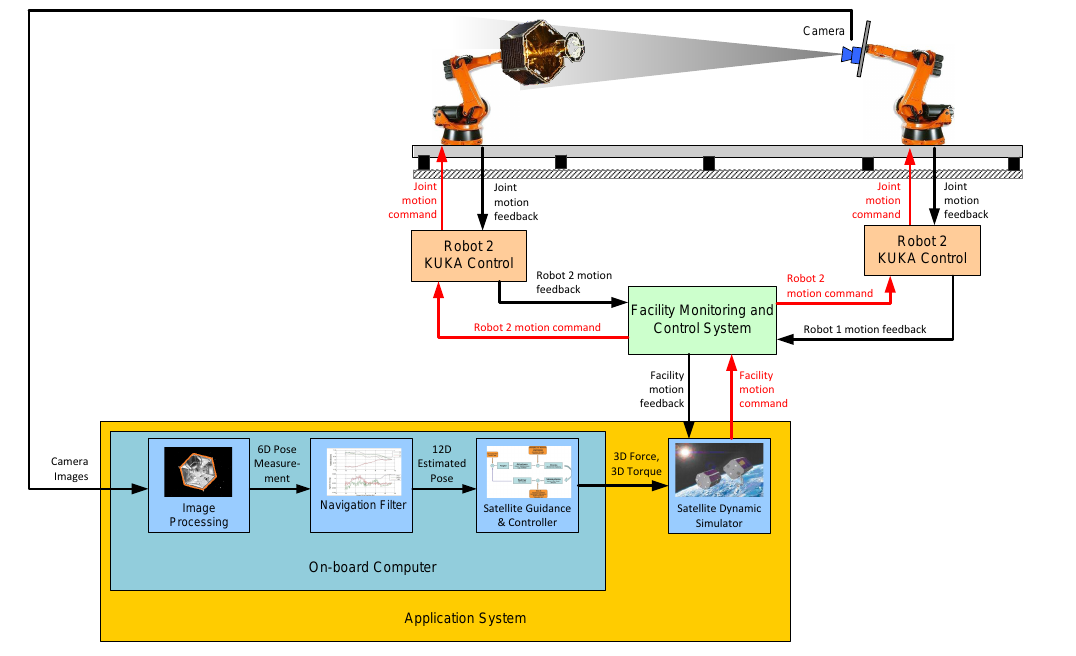
Figure 19: Hardware-in-the-Loop Simulation involving a camera as rendezvous sensor and an on-board